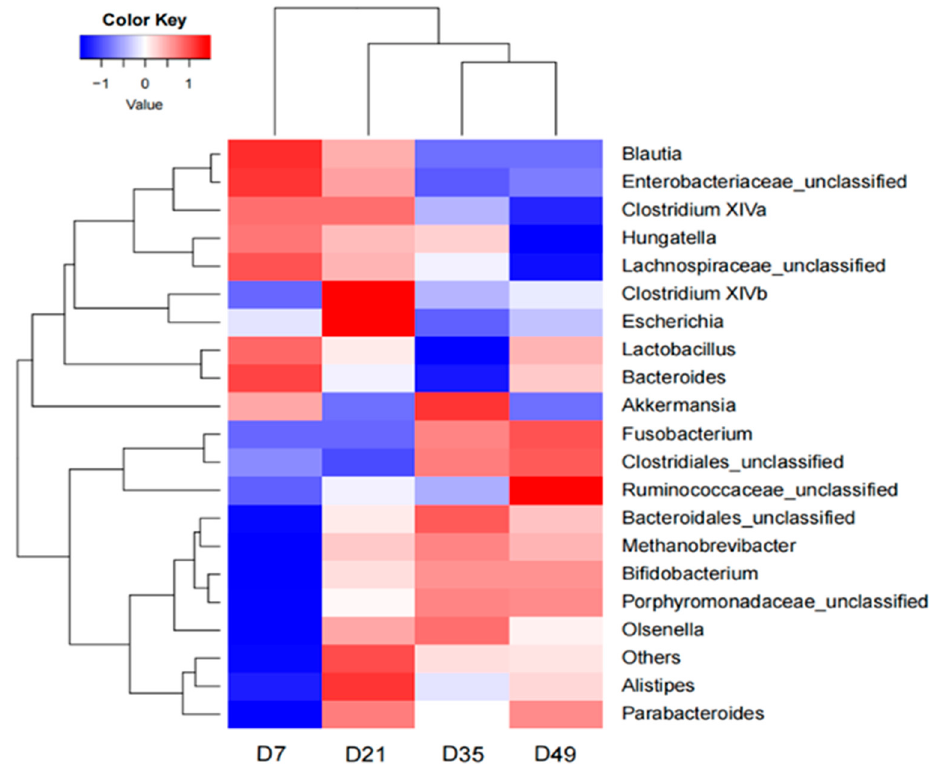
Figure 4. Heat map of the genus-level taxonomic composition in the early lambs at four sampling time points. The colors in the heat map represent the normalized relative abundances of genera (Log 10): red to blue represents more abundant to less abundant.